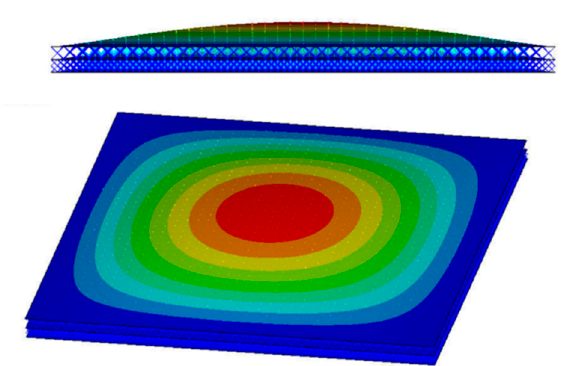
Figure 10. Model of Bi-layer lattice-filled sandwich plate.